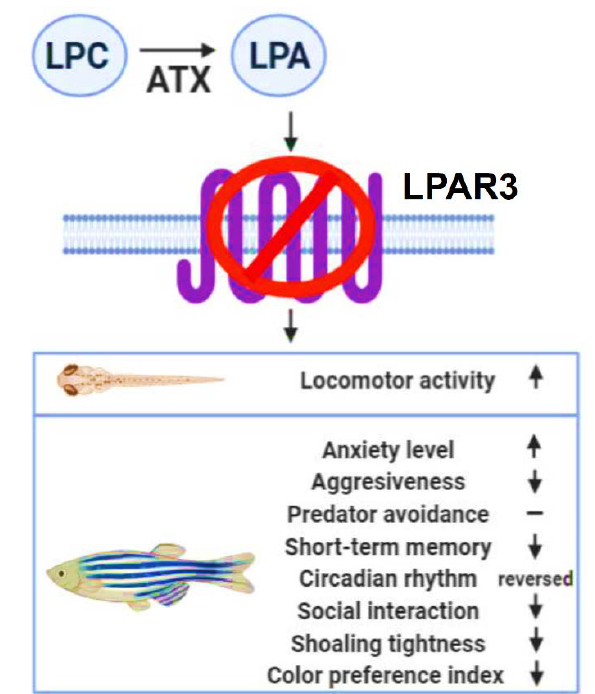
Figure 9. Schematic representation of the behavioral signatures detected in lpar3 knockout zebrafish. LPA converted by autotaxin (ATX) from lysophosphatidylcholine (LPC), mediates numerous signaling pathways through LPA receptors. The novelty of this study was to identify that LPAR3, one of LPARs, plays multiple roles in modulating behaviors in zebrafish at both the larva and adult stages.